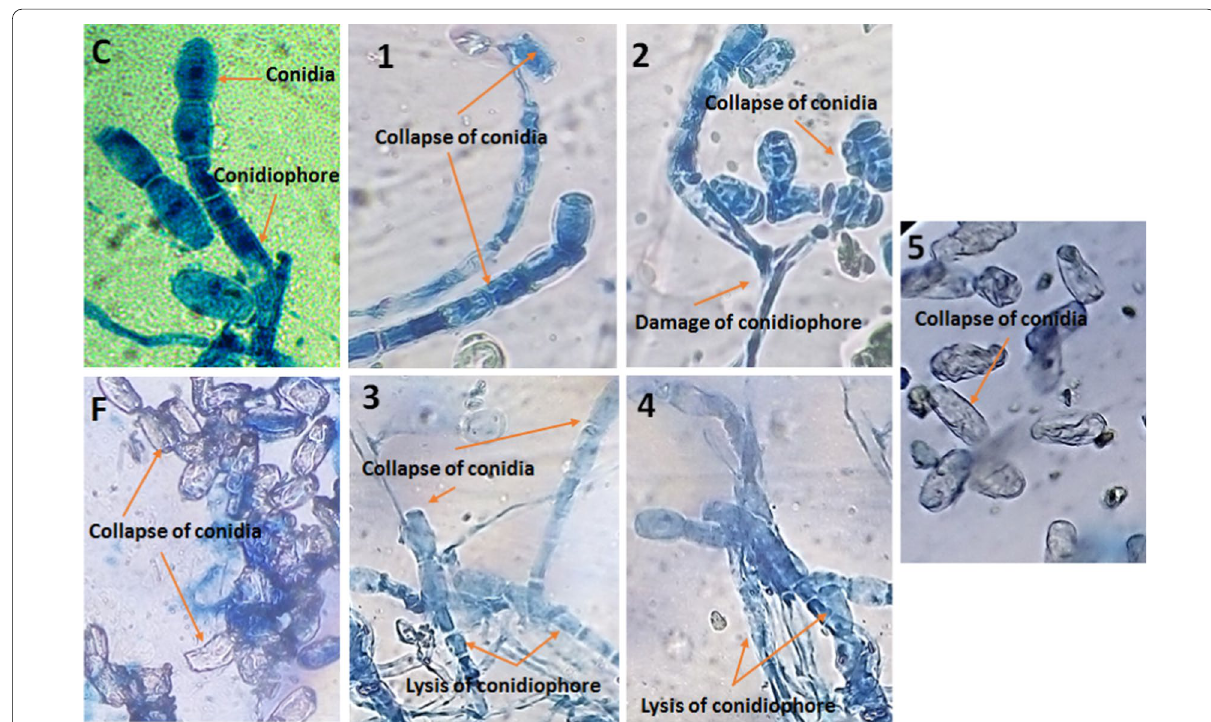
Fig. 2 Light microscope observations of hyphae, conidiophores and conidia of Golovinomyces cichoracearum collected from sunflower leaf surface sprayed with all treatments showing, C: untreated control with normal conidia and conidiophores. 1 : Bacillus subtilis , 2 : B. pumilus , 3 : Trichoderma harzianum , 4 : T. viride , 5 : T. koningii and F: fungicide (Vectra) showing twisting and lysis of hyphae and conidiophores and conidial shrinking and collapsing, (400 ) ×